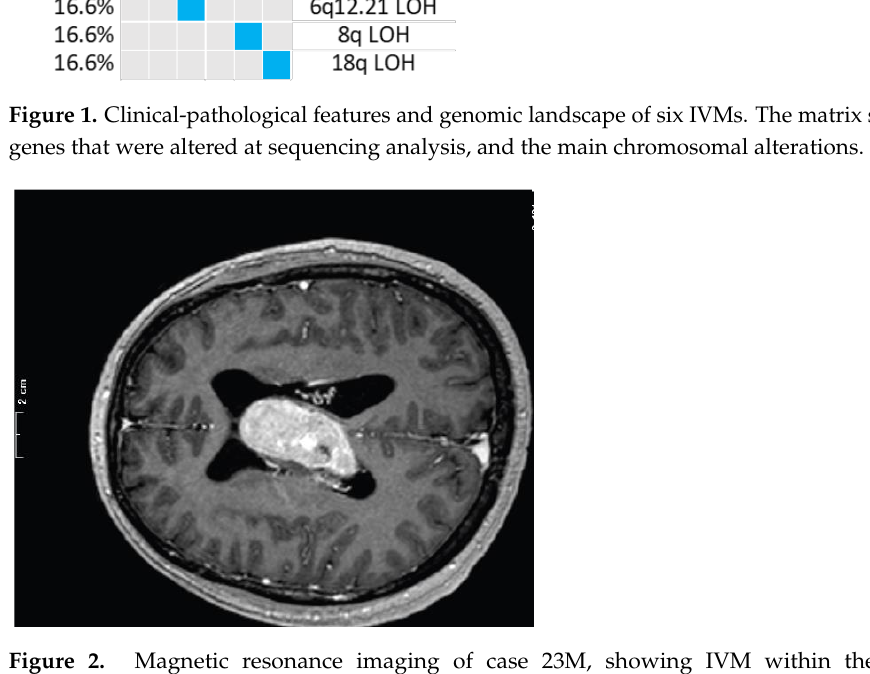
Figure 2. Magnetic resonance imaging of case 23M, showing IVM within the third and lateral ven-